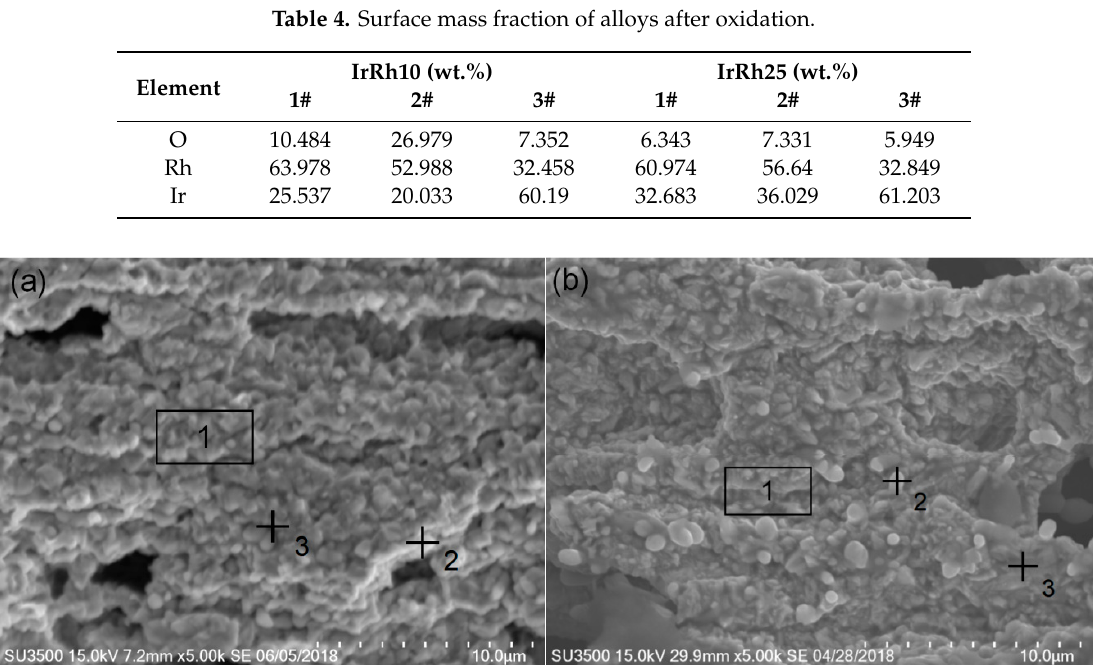
Figure 6. Surface energy spectra tests area and points of ( a ) IrRh10 and ( b ) IrRh25 after high-temperature oxidation. Table 4. Surface mass fraction of alloys after oxidation.